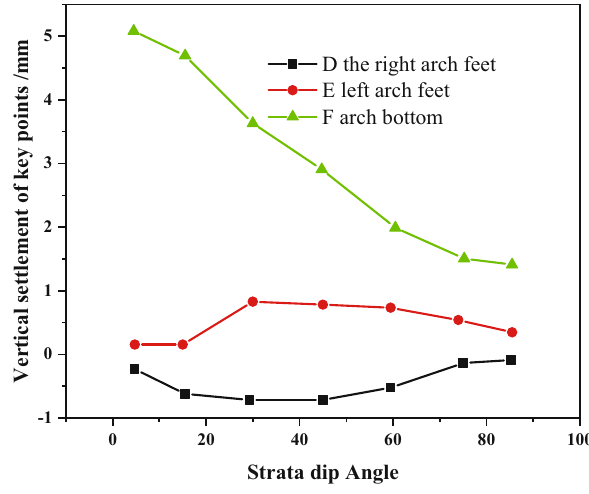
Figure 5: Vertical displacement curve 2 of key points.